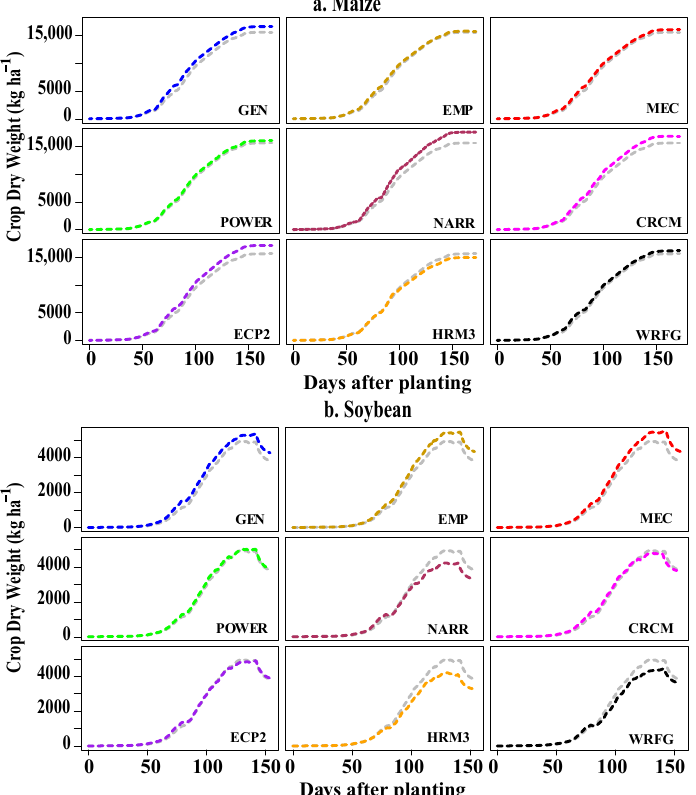
Figure 11. Growing season accumulated crop dry weight (CWAD) simulated from the different sources of estimated solar radiation (color) and observations (gray) during 1993 for ( a ) maize and ( b ) soybean. Note the change in the scale of the vertical axis between maize and soybean. See Figure 2 for definition of abbreviations. For both crops, planting occurred on April 1. For reference, the timing of crop stages for the 1993 simulations using observed radiation, in terms of days after planting, for maize (soybean) was 86 (74) for anthesis and 172 (142) for maturity.